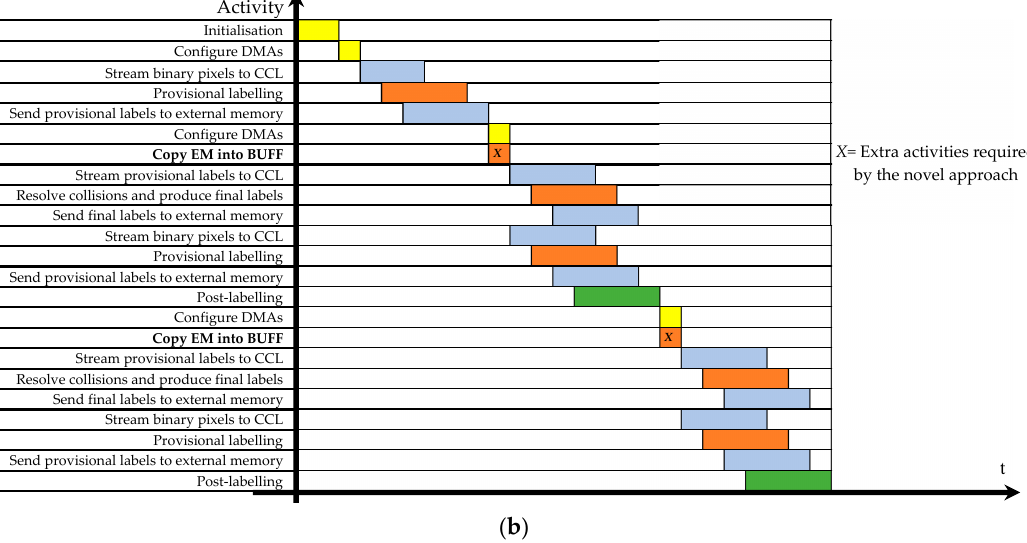
Figure 2. Activities as performed by ( a ) a conventional two-scan connected component labeling (CCL), and ( b ) the new parallel CCL.